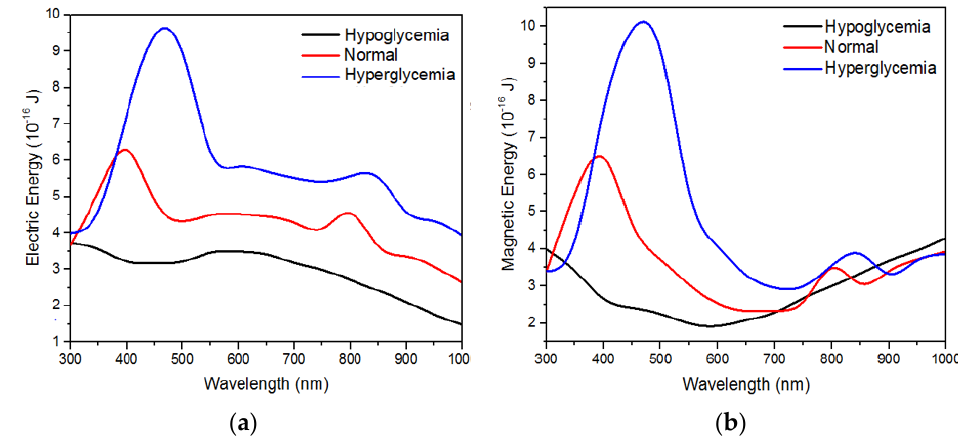
Figure 9. Simulation results of ( a ) electric energy and ( b ) magnetic energy on the ZnO nanosquare in hypoglycaemia (75 mg/dL), normal (100 mg/dL), and hyperglycemia (130 mg/dL) blood media.